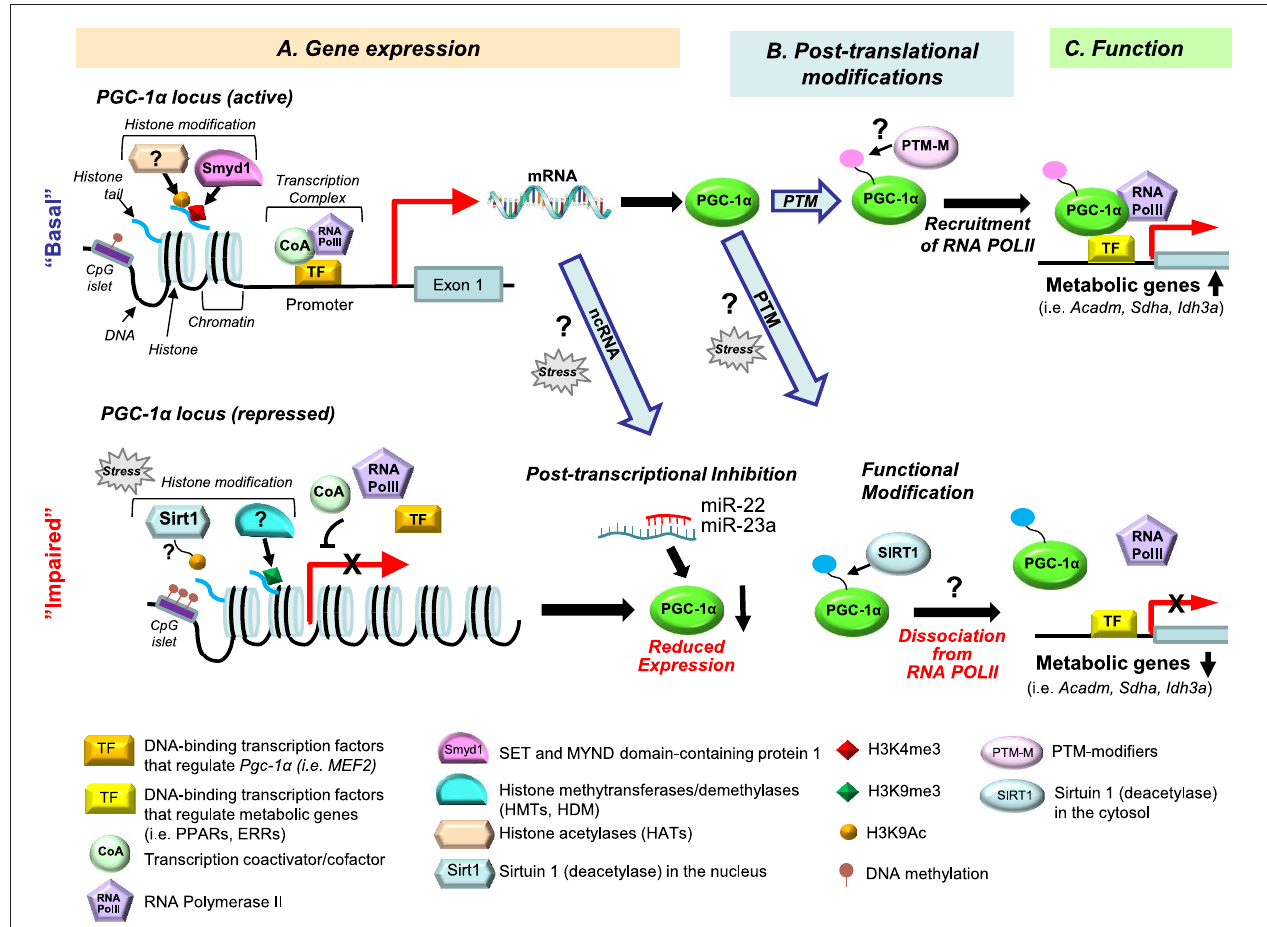
FIGURE 1 | Multiple levels of PGC-1 α signaling dysregulation in heart failure. Dysregulation of the PGC-1 α regulatory cascade can occur at the level of gene expression (A) , post-translational modifications (PTM) (B) , and PGC-1 α function (C) . (A) At the gene expression level, the PGC-1 α cascade can be modulated via histone modifications ((de)methylation and (de)acetylation), DNA (de)methylation, by various transcription factors [TFs, reviewed in ( 17)], and via post-transcriptional inhibition of the PGC-1 α gene by non-coding (nc) RNAs. The histone methyltransferase Smyd1 increases promoter activity of PGC-1 α through regulating the enrichment of the H3K4me3 levels (a gene activation mark) (26). In different animal models of heart failure, reduced expression of PGC-1 α was associated with increased H3K9me3 level (a gene repression mark) (27) or a decreased level of H3K9Ac (a gene activation mark) (28). Sirtuin 1 (Sirt1) is a plausible histone deacetylase (HDAC) for gene repression of PGC-1 α under pressure overload ( 28), but this remains to be established. DNA hypermethylation is known to suppress PGC-1 α in the skeletal muscle (29–31), but little is known about its role in PGC-1 α regulation in the heart (32). The protein expression level of PGC-1 α can be reduced through post-transcriptional inhibition by miRNAs, such as miR-22 ( 33) and miR-23a (34), but it is unknown whether small ncRNA-mediated PGC-1 α repression occurs in heart failure. (B) PGC-1 α activity is known to be regulated by posttranslational modifications (PTMs), including phosphorylation and acetylation [reviewed in (17)]. However, which PTMs of PGC-1 α are specific for the development of heart failure remains unknown. Sirt1 deacetylases the PGC-1 α protein (35), but it is not known whether this PTM is a part of PGC-1 α dysregulation in the failing heart. (C) PGC-1 α ’s transcriptional control of metabolic genes (i.e., Acadm, Sdha, Idh3a )